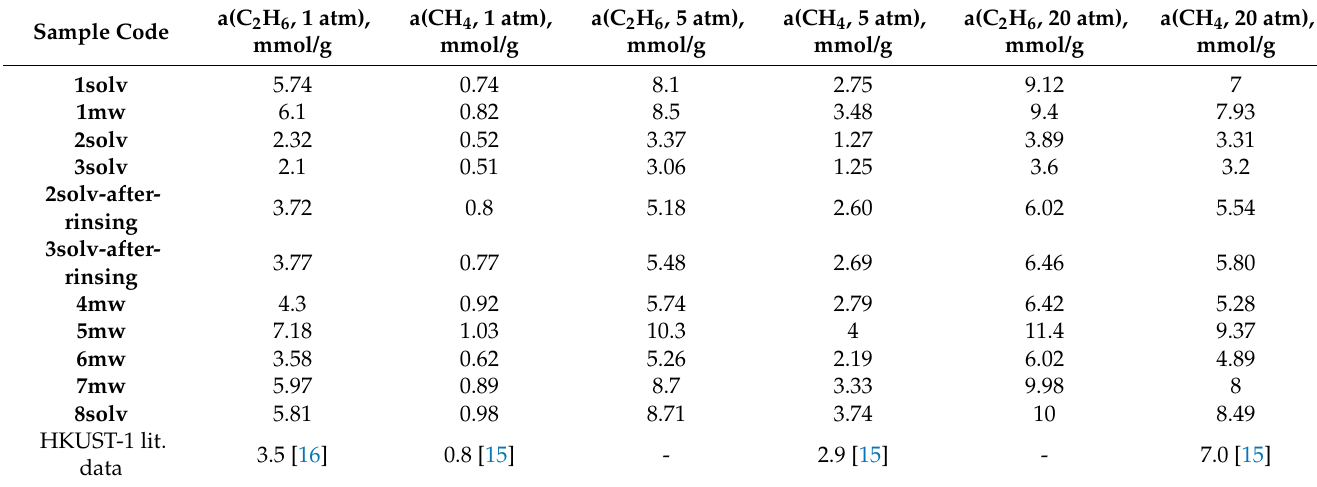
Table 3. Adsorption capacities of synthesized HKUST-1 materials towards methane and